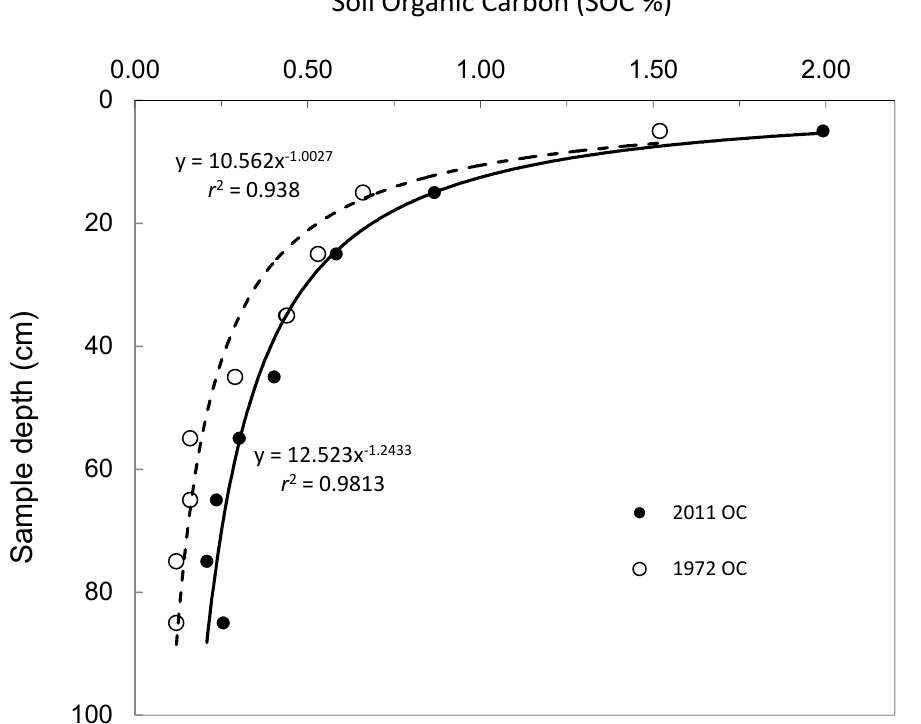
Figure 1. Soil organic carbon content (SOC) as a function of soil depth in 1972 and 2011 in a designated sample site in south-western Victoria.